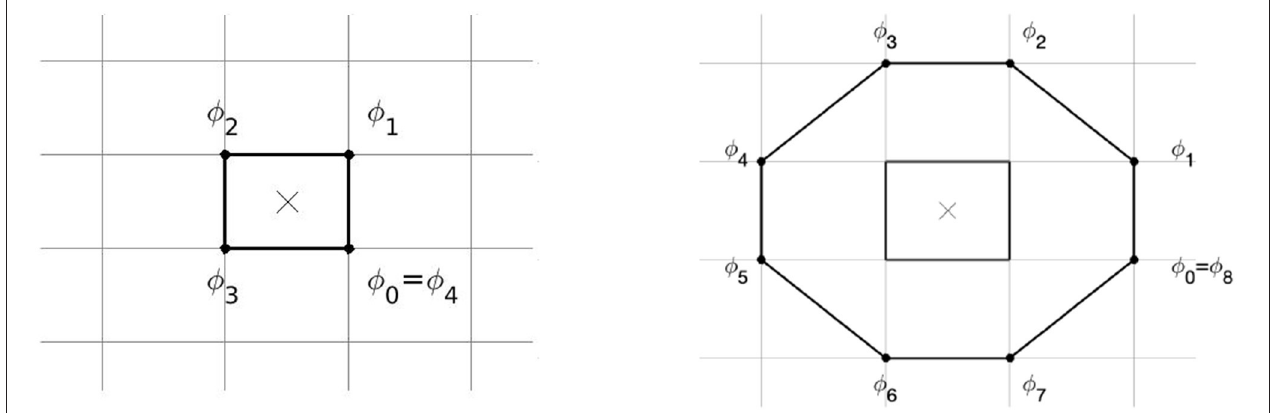
FIGURE 3 | Method of PS detection by Kuklik et al. (2017) as used in this paper. Phase differences are considered between pairs of points on a ring of 4 points ( Left , 2 2 method) or 8 points ( Right , 4 4 method), to assess whether a PS is present at the central × ×